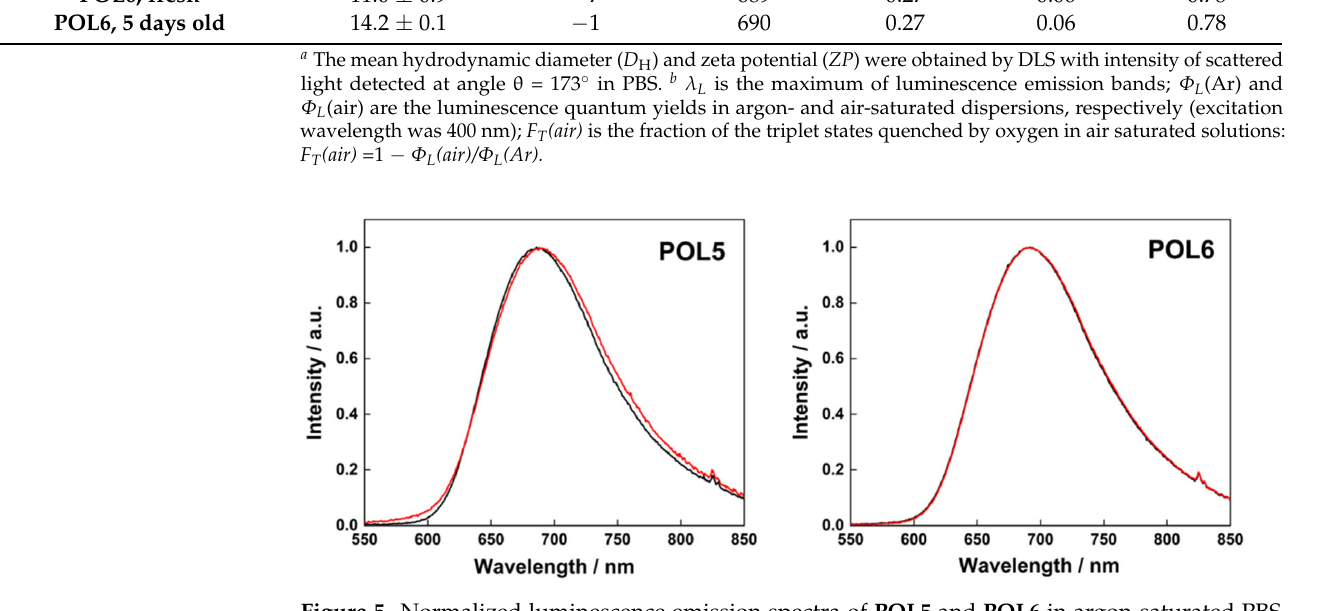
Figure 5. Normalized luminescence emission spectra of POL5 and POL6 in argon-saturated PBS. Solutions were fresh (black curve) or 5 days old (red curve). All samples were excited at 400 nm.